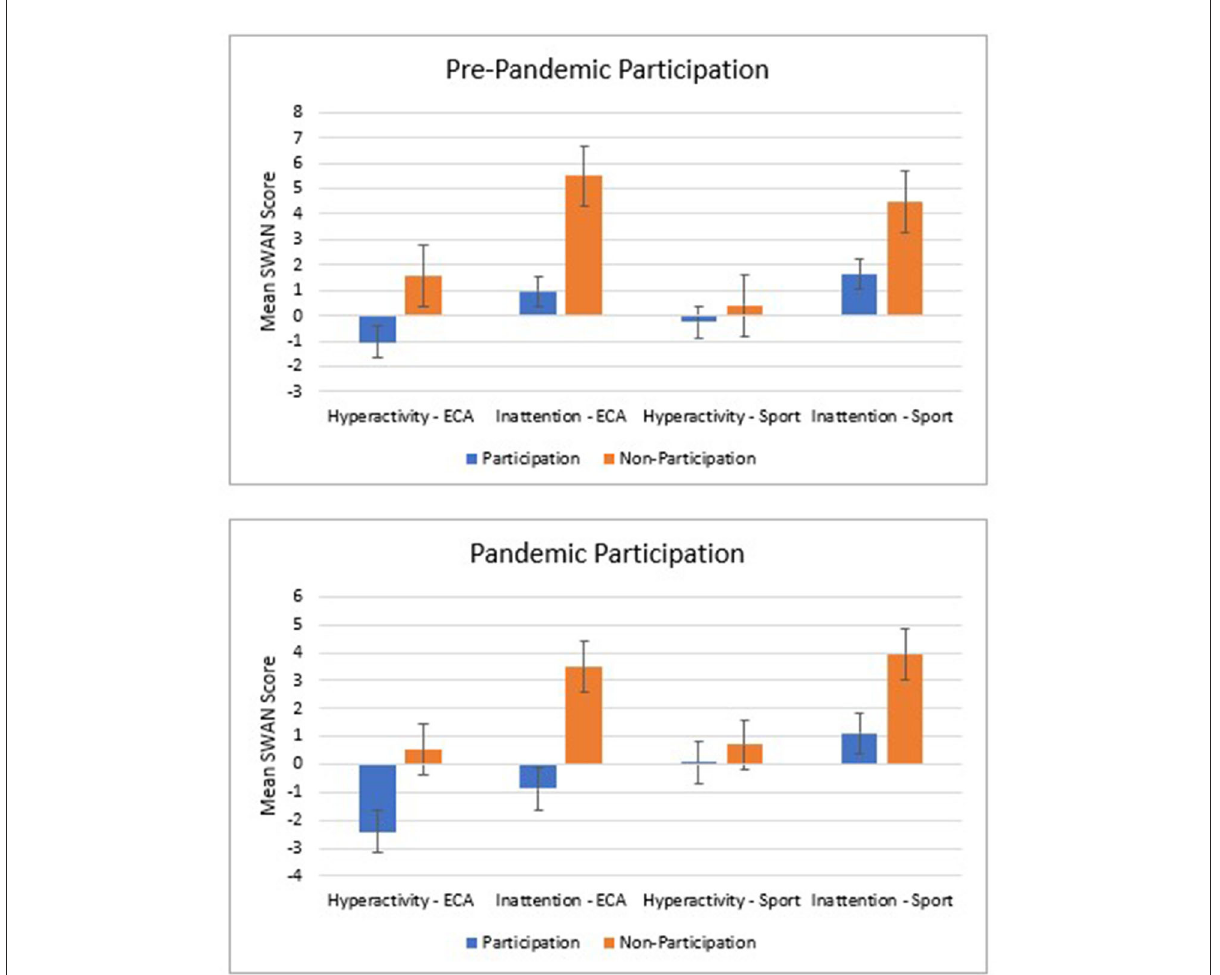
FIGURE3 Mean hyperactivity and inattention symptoms in extracurricular activities and sports pre-COVID and during-COVID participation. ECA, extracurricular activities; Hyperactivity and inattention symptoms were reported by parents though the SWAN (Strengths and Weaknesses of ADHD symptoms) subscales; Error bars represent standard